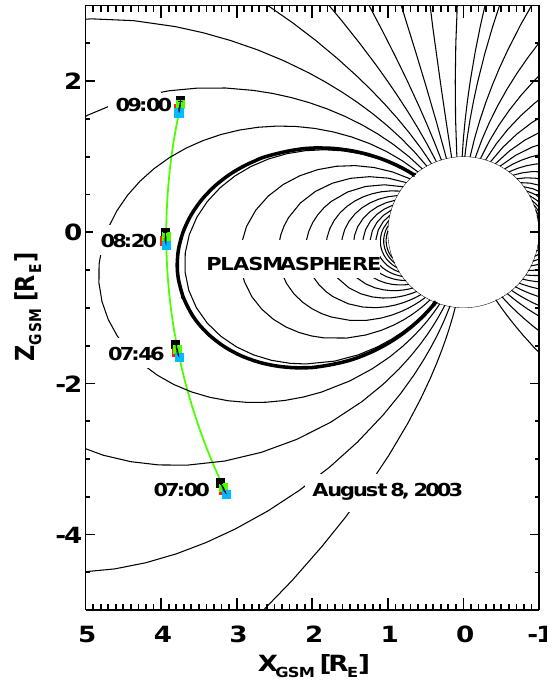
Fig. 1. The Cluster orbits in the dayside magnetosphere on 8 Au- gust 2003, 07:00 and 09:00UT. The ULF pulsation investigated is detected between 07:46 and 08:20UT. The thick black line marks the plasmapause at L = 4 . 23 R E .